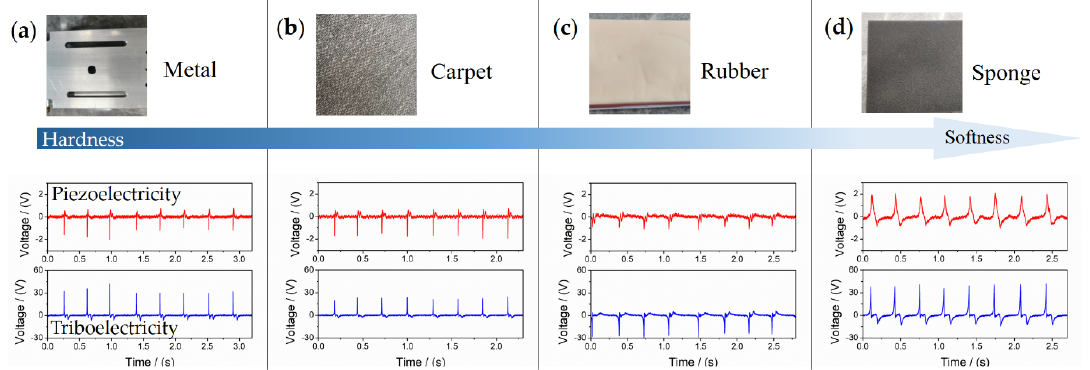
Figure 8. Analysis of specific response behaviors to hardness recognition. The double signal is generated from hitting different objects under vertical force, including: ( a ) metal, ( b ) carpet, ( c ) rubber, and ( d ) sponge.